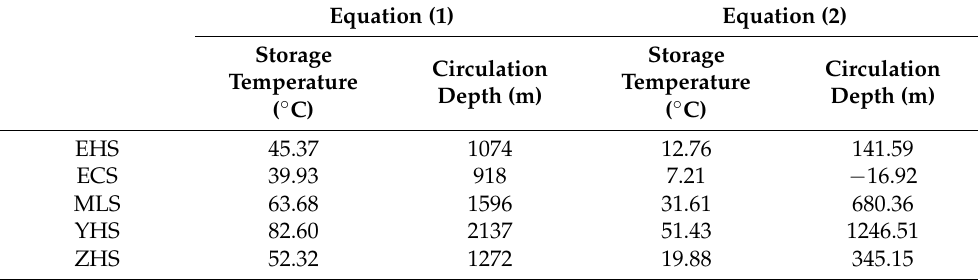
Table 4. Calculation results of thermal storage temperature of hot